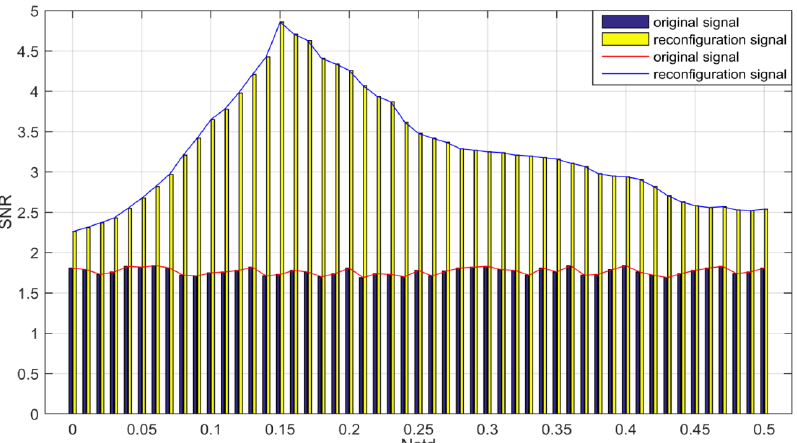
Figure 5. SNR-Nstd (Signal to noise ratio -Noise of the standard deviation of the added) diagram.